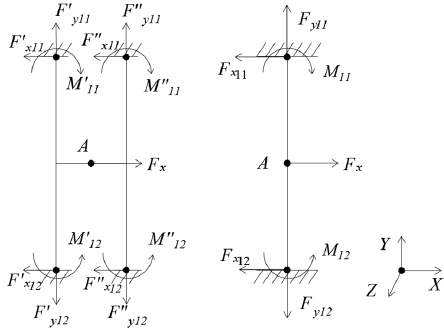
Figure 3. Mechanical models of floating beam and H-beam under F x.